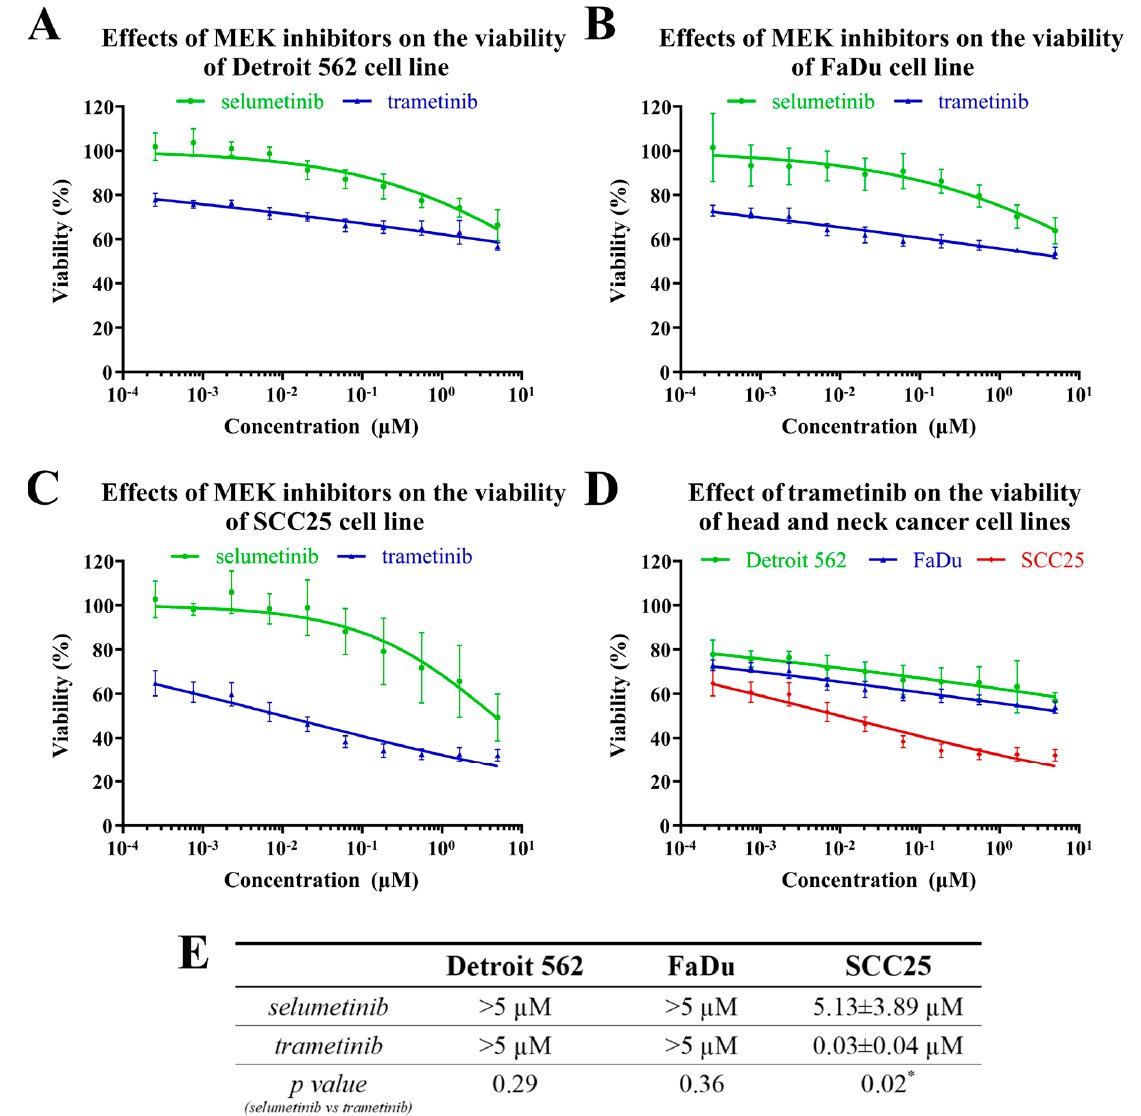
Figure 4. The effects of MEK inhibitors on head-and-neck-cancer-cell viability. The HNSCC cell lines were treated with selumetinib or trametinib at different concentrations for 72 h and cell viability was determined by MTT assay. The IC 50 curves of the effects of the inhibitors on Detroit 562 ( A ), FaDu ( B ) and SCC25 ( C ) cell lines are shown. The IC 50 curves of the effects of the trametinib on the three HNSCC cell lines are shown in a common diagram ( D ) for better comparison. ( E ) The IC 50 values of the effects of the MEK inhibitors on Detroit 562, FaDu and SCC25 cells. All data are represented as the mean ± SD of five independent measurements. The IC 50 values ( E ) of the two inhibitors were compared to each other and Student’s t -tests were performed for statistically significant differences; * p < 0.05 selumetinib vs.